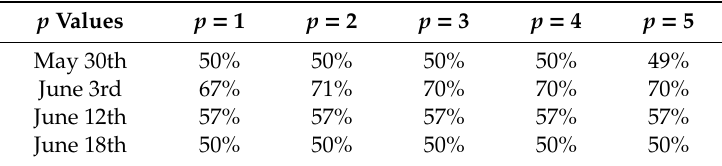
Table 1. Comparing the prediction accuracy for di ff erent powers ( p ). p